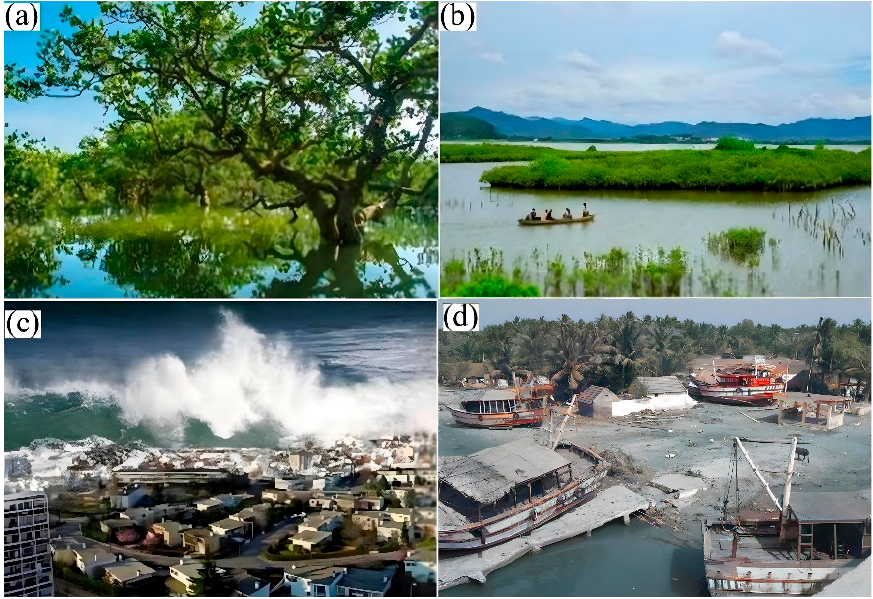
Figure 1. Examples of mangroves and their disaster preparedness: ( a ) mangrove plants (http://www.forestry.gov.cn/main/416/20201209/094618527742186.html (accessed on 9 December 2020)), ( b ) mangrove habitat (http://k.sina.com.cn/article_5787187353_158f1789902000iq61.html (ac ‐ cessed on 19 November 2018)), ( c ) the 2004 Indian Ocean tsunami (https://www.sohu.com/a/205476684_644208 (accessed on 20 November 2017)), and ( d ) Singarathop fishing village [4].